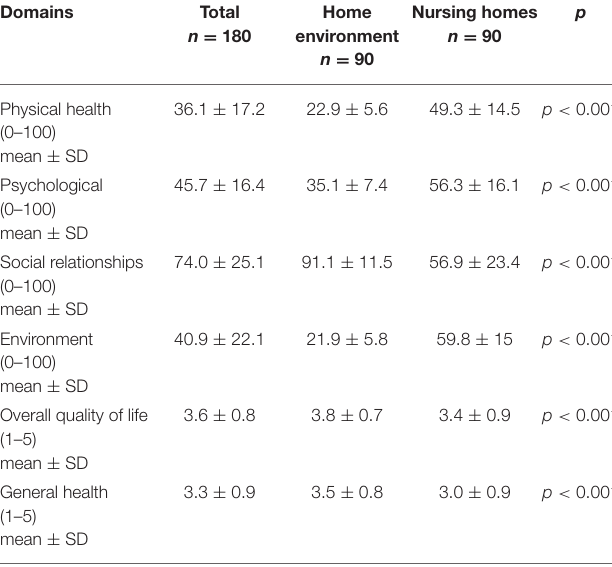
TABLE 4 | Quality of life assessment carried out with the WHOQOL-Bref questionnaire in the study group ( n = 180).